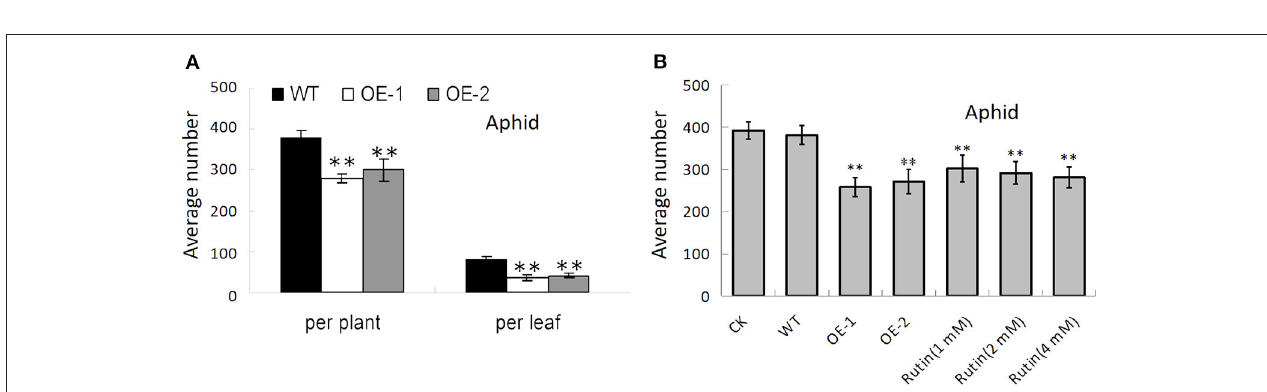
FIGURE 7 | AtMYB12 overexpression enhanced insect resistance in tobacco plants. (A) Insect bioassay for aphids on wild-type (WT), AtMYB12 overexpression tobacco (OE-1 and OE-2). (B) Insect bioassay for aphids on WT, AtMYB12 overexpression tobacco (OE-1 and OE-2), WT tobacco pre-sprayed with water (CK) or 1, 2, 4mM rutin. The values are the means ± SD ( n = 12, * p < 0.05, ** p <